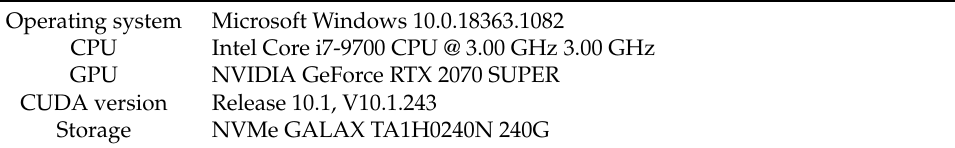
Table 1. Hardware and software environment.